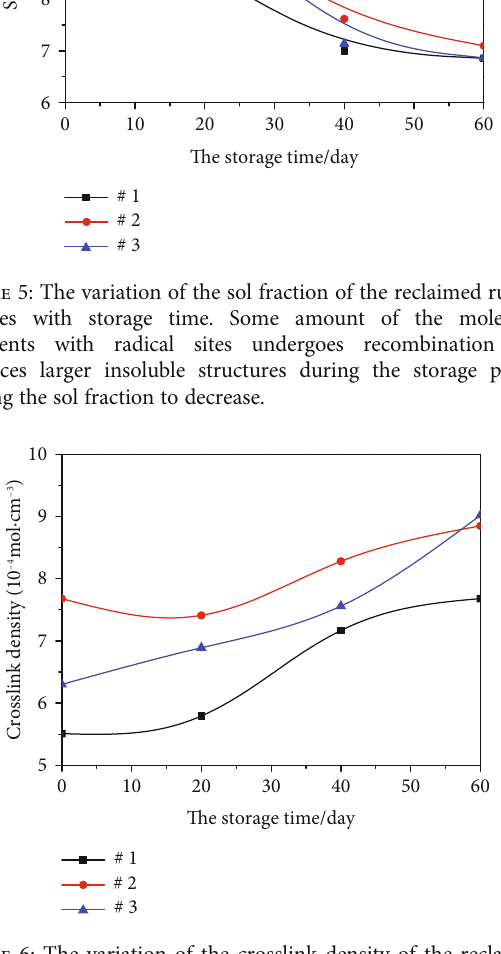
Figure 6: The variation of the crosslink density of the reclaimed rubber samples with storage time. The crosslink density increased with increasing storage days, and due to the higher e ff ectiveness of the two-roll milling process in breaking down the crosslinks, the #1 reclaimed rubber sample had a lower crosslink density than the other two samples, passing through an extruder (#2) and rubber strainer